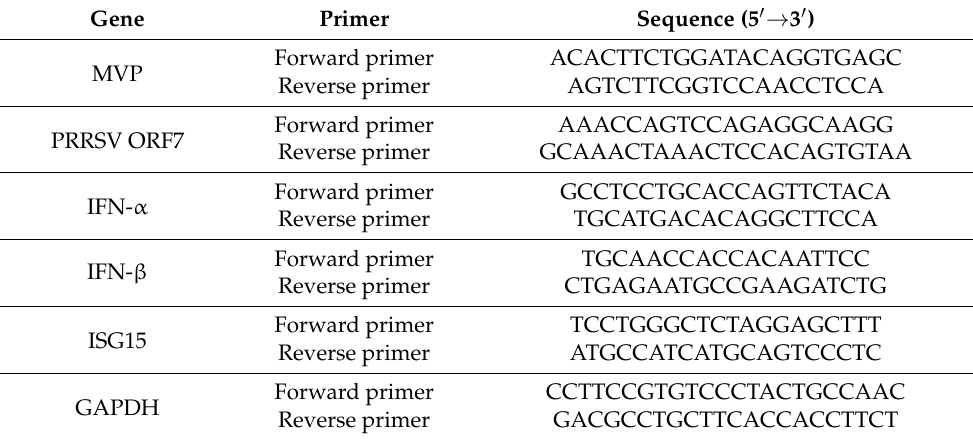
Table 1. The sequences of primers used in this study for real-time RT-PCR.